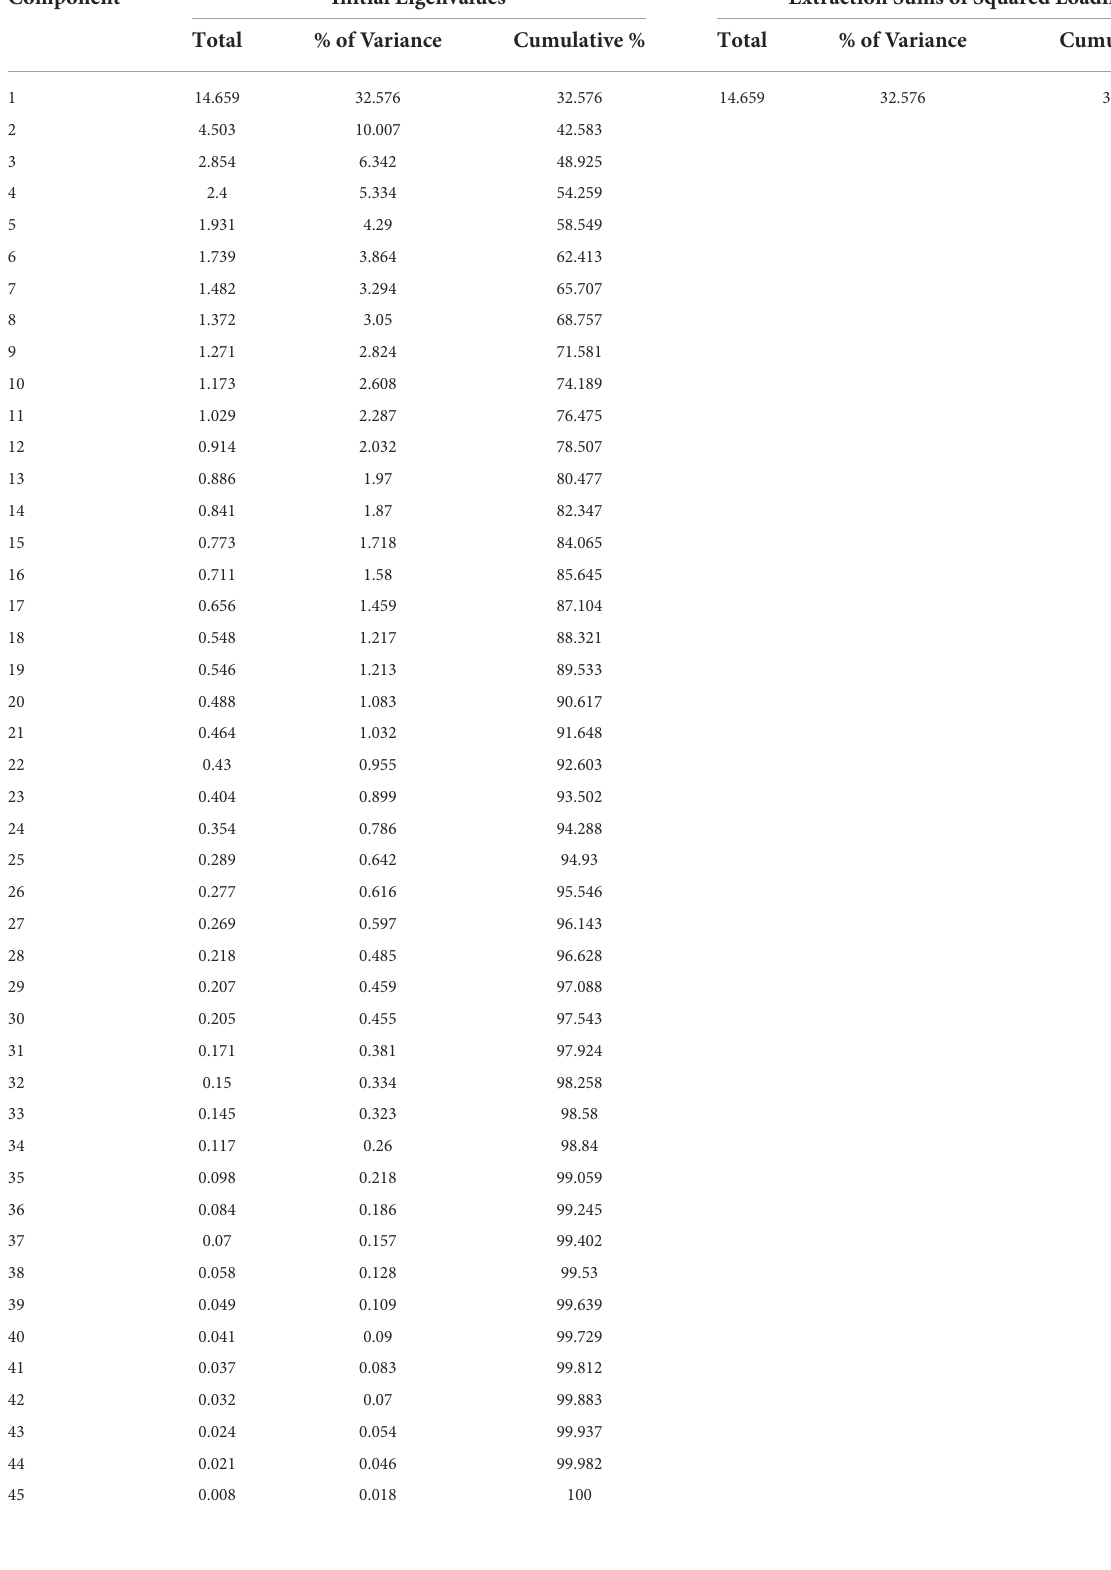
TABLE 2 Common method